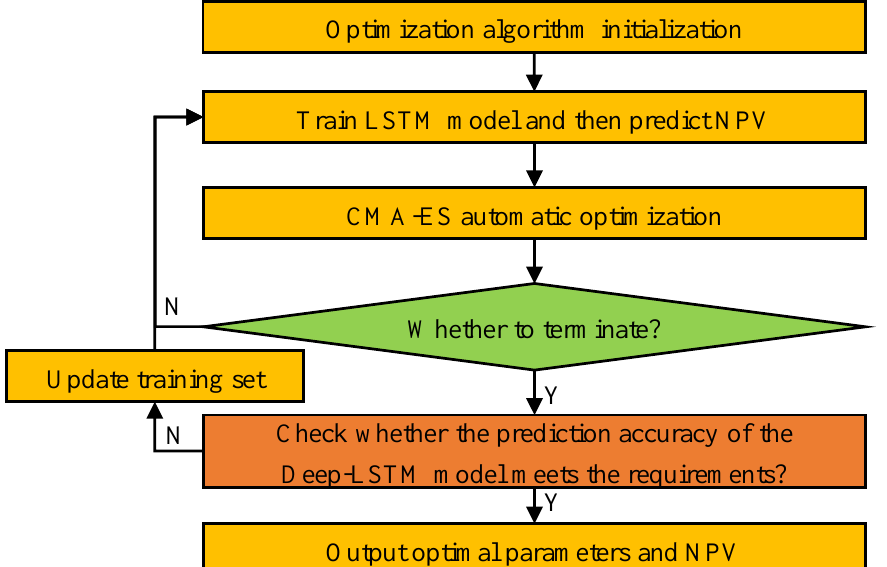
Figure 5. CMA-ES optimization process.